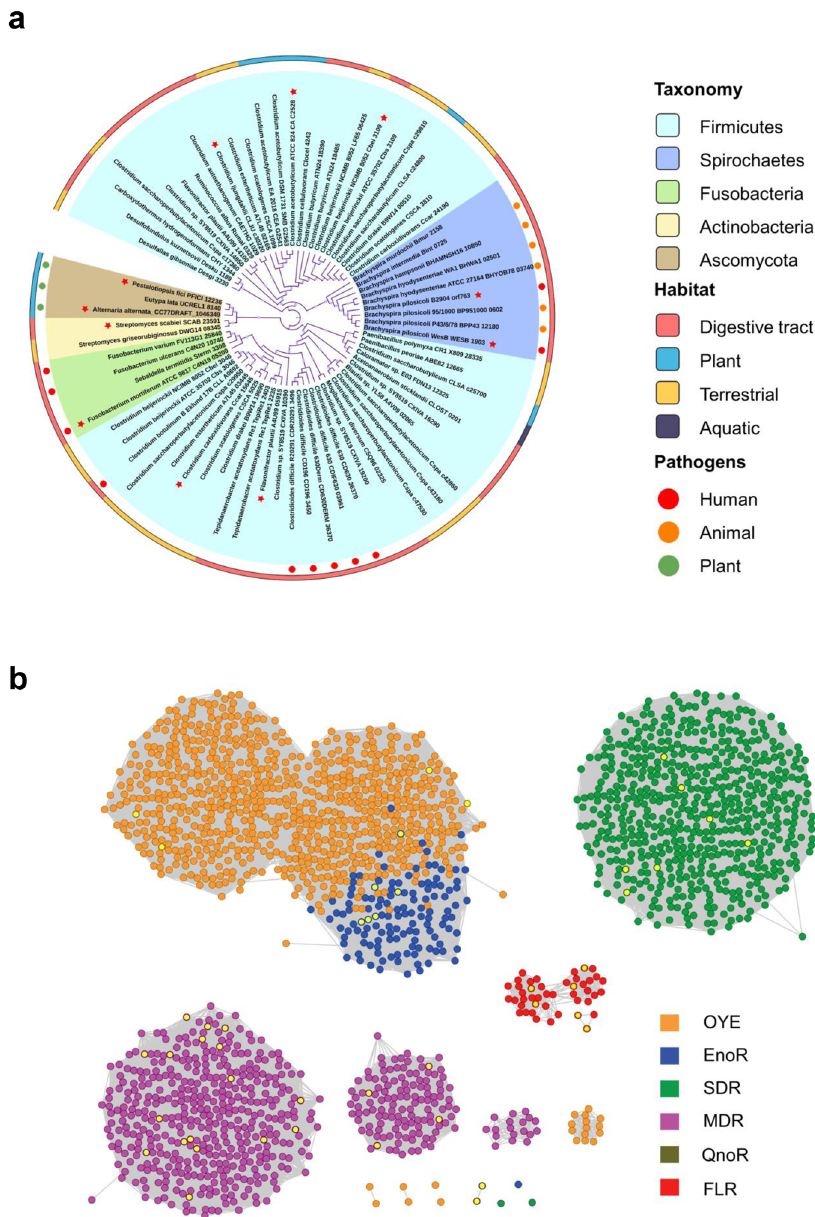
Fig. 3 Bioinformatic and experimental analysis identify that fl avone reductases (FLRs) are a distinct group of ene-reductases. a Phylogenetic analysis of FLRs. The maximum-likelihood phylogenetic tree is based on the protein sequences of putative FLR enzymes found in Ascomycota, Firmicutes, Spirochetes, Fusobacteria, and Actinobacteria. Light purple circles on branches indicate bootstrap values greater than 0.7 from 300 bootstrap replicates. The FLR-like enzymes highlighted with red stars were chosen to assay the in vitro activity towards the fl avone apigenin. b A sequence similarity network (SSN) for the ene-reductases. The network was generated with an initial score of 10 − 20 and the “ alignment score threshold ” (that is a measure of the minimum sequence similarity threshold) for drawing the edges that connect the proteins (nodes) in the SSN was then re fi ned such that nodes are connected by an edge if this value is ≥ 40. Each of the nodes represents proteins with ≥ 90% amino acid sequence identity and was colored according to the cluster type (OYE, EnoR, SDR, MDR, QnoR, and FLR). Each type of ene-reductase, as shown in a different color, is separated into different clusters that may contain enzymes with similar biochemical activity. A total of 72 different FLR-like proteins which are shown in the phylogenic tree are denoted in red. The nodes representing the reported ene-reductase with enzyme activity data (from BRENDA Enzyme Database) and biochemically identi fi ed FLR-like enzymes in this study were highlighted with lemon yellow. OYE, Old-Yellow-Enzyme; EnoR, oxygen-sensitive enoate reductases; SDR, short-chain dehydrogenase/reductase; MDR, medium-chain dehydrogenase/reductase; QnoR, quinone reductase-like